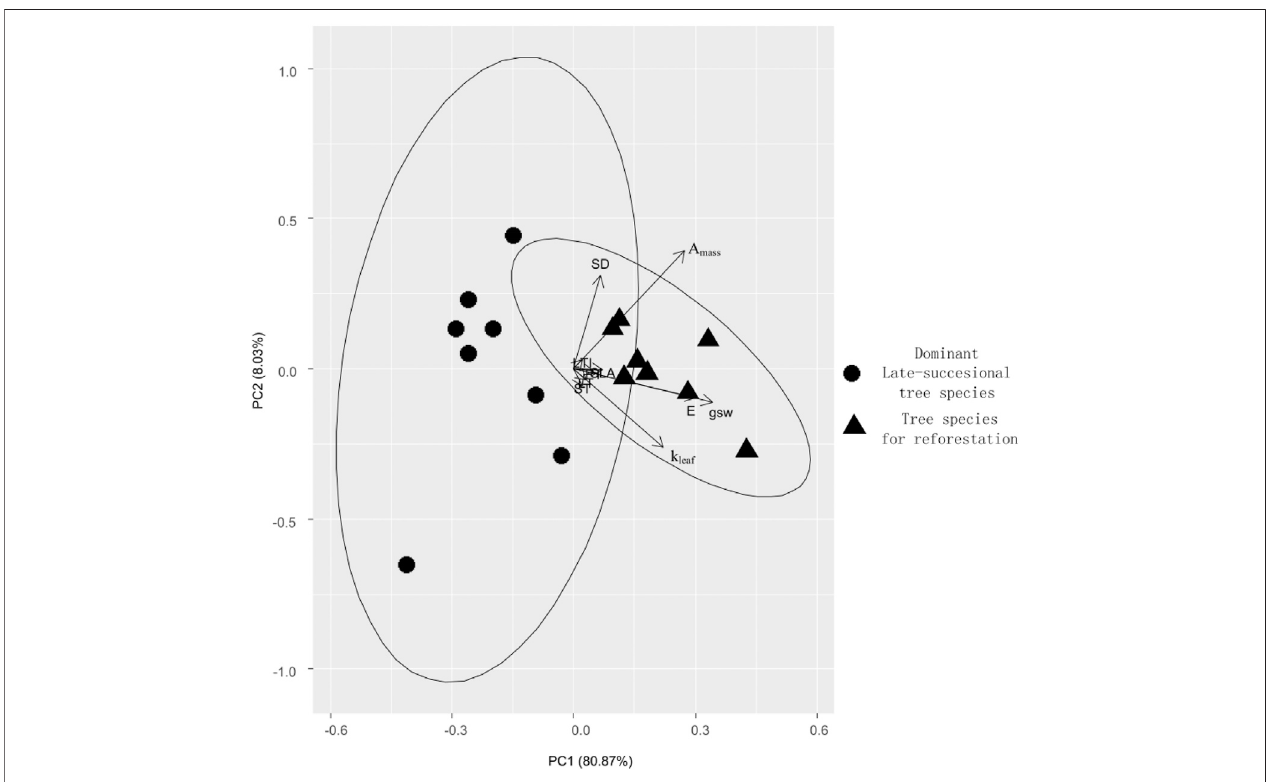
FIGURE 4 | Principal component analysis (PCA) of the ten functional traits associated with fast growth between the eight separately monocultured fast-growing tropical tree species (tree species for reforestation) and the eight dominant tropical tree species in the undisturbed old-growth tropical rain forest (dominant late- successional tree species).